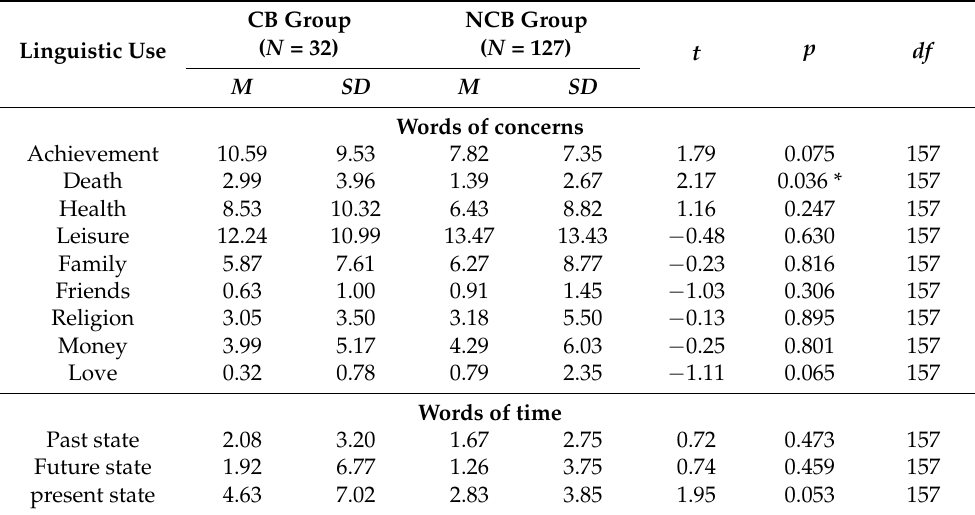
Table 2. Linguistic Difference between CB group and NCB